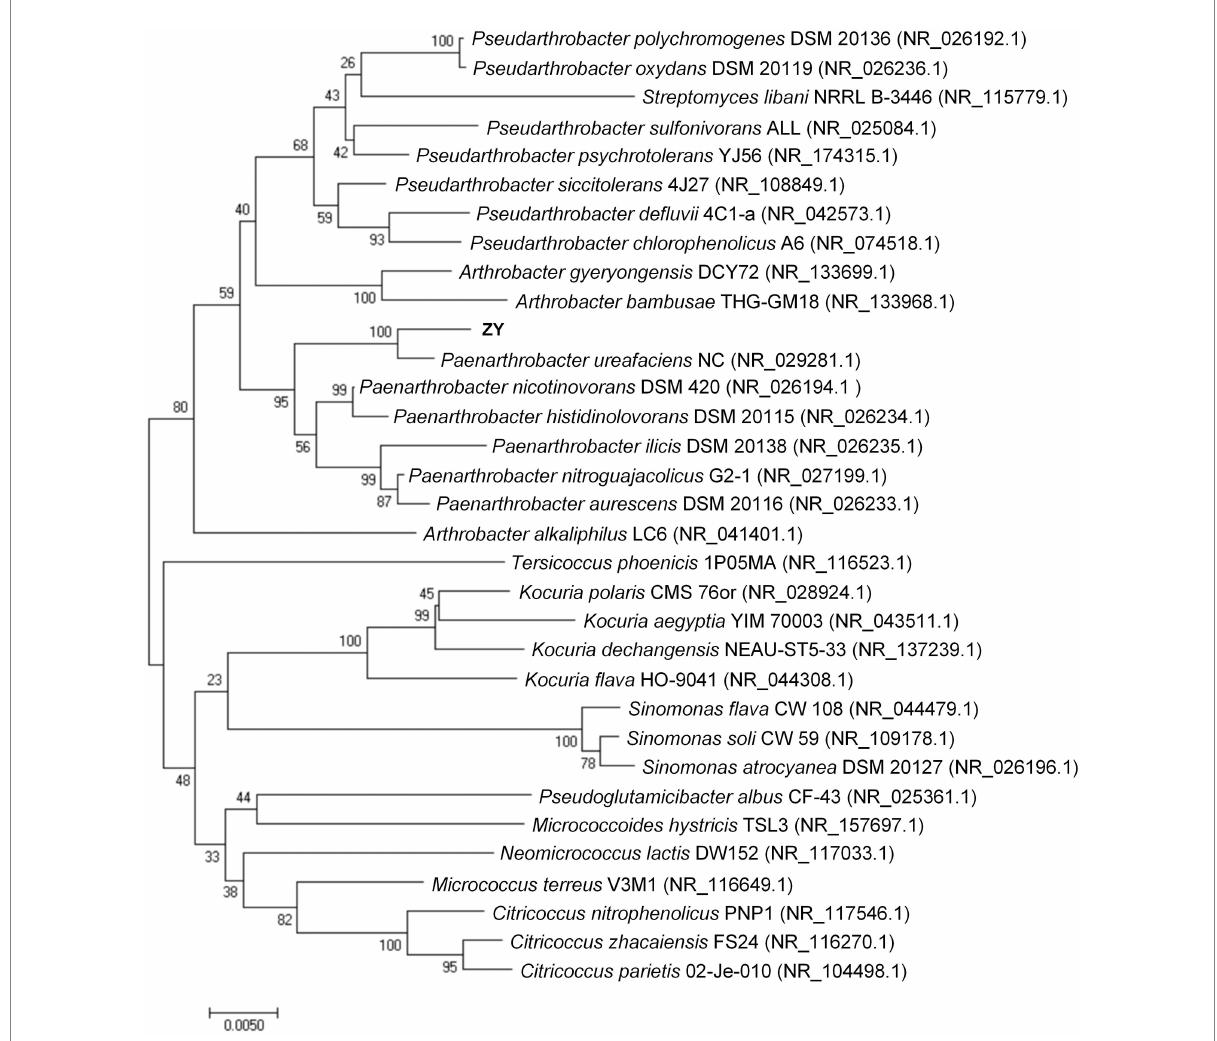
FIGURE 1 Phylogenetic tree based on the 16S rRNA gene sequences of strain ZY. The calculations were performed according to a neighbor-joining analysis (bootstrap number = 1,000), and the bar indicates 0.0050 substitution per nucleotide